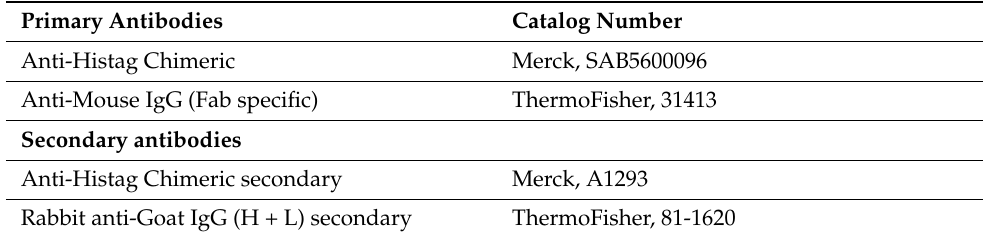
Table 1. List of antibodies used for Western Blot.